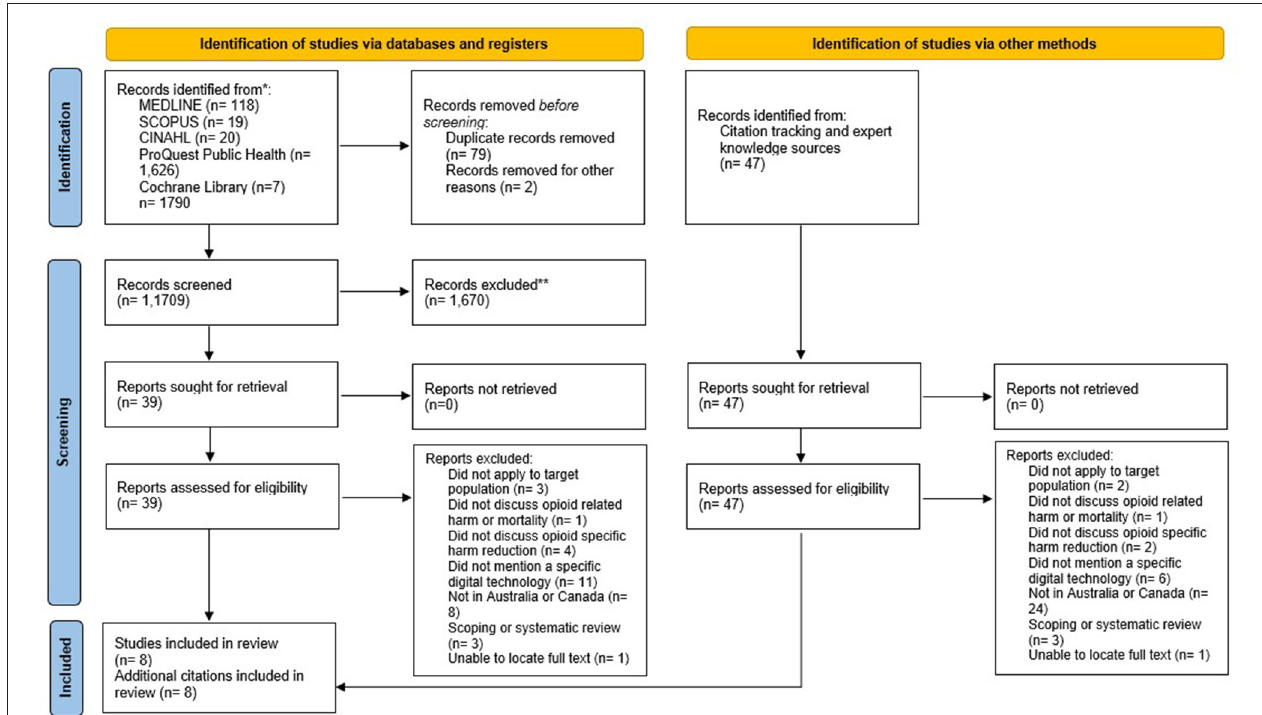
FIGURE 1 | PRISMA-ScR 2020 flow chart of paper identification and selection